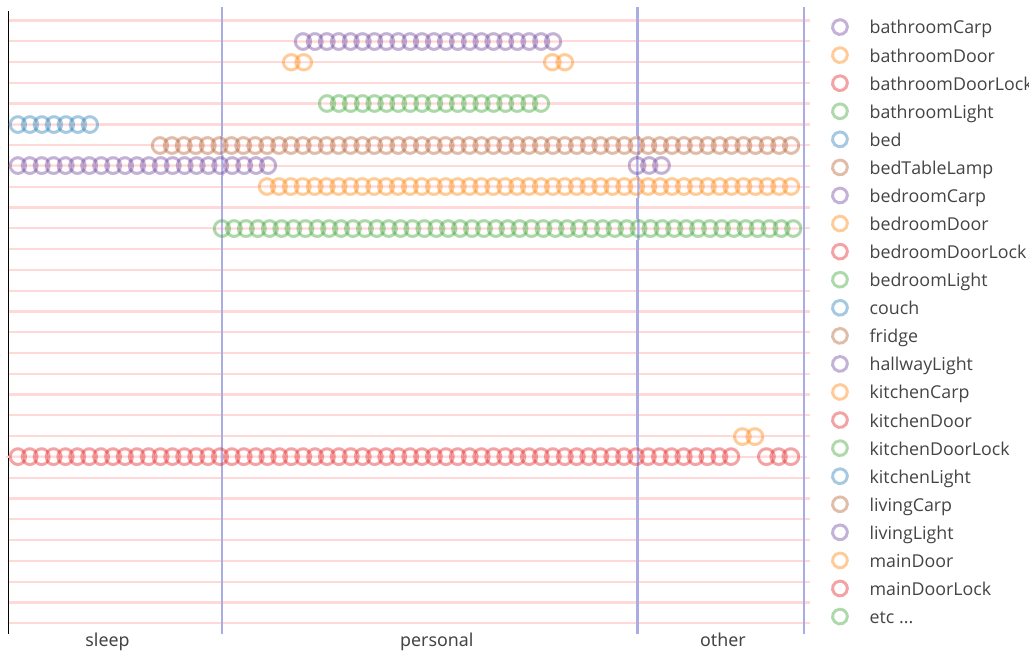
Figure 6. Twenty-nine binary sensors’ output and the corresponding activity